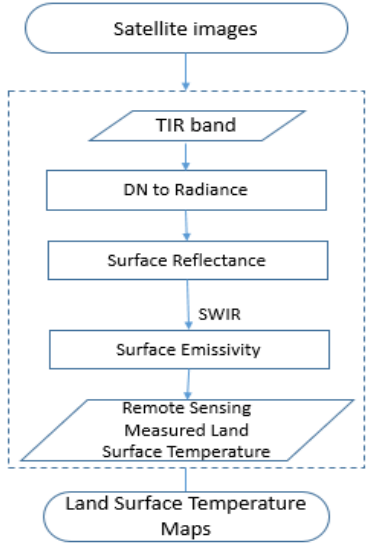
Figure 11. Flow Chart for Land surface